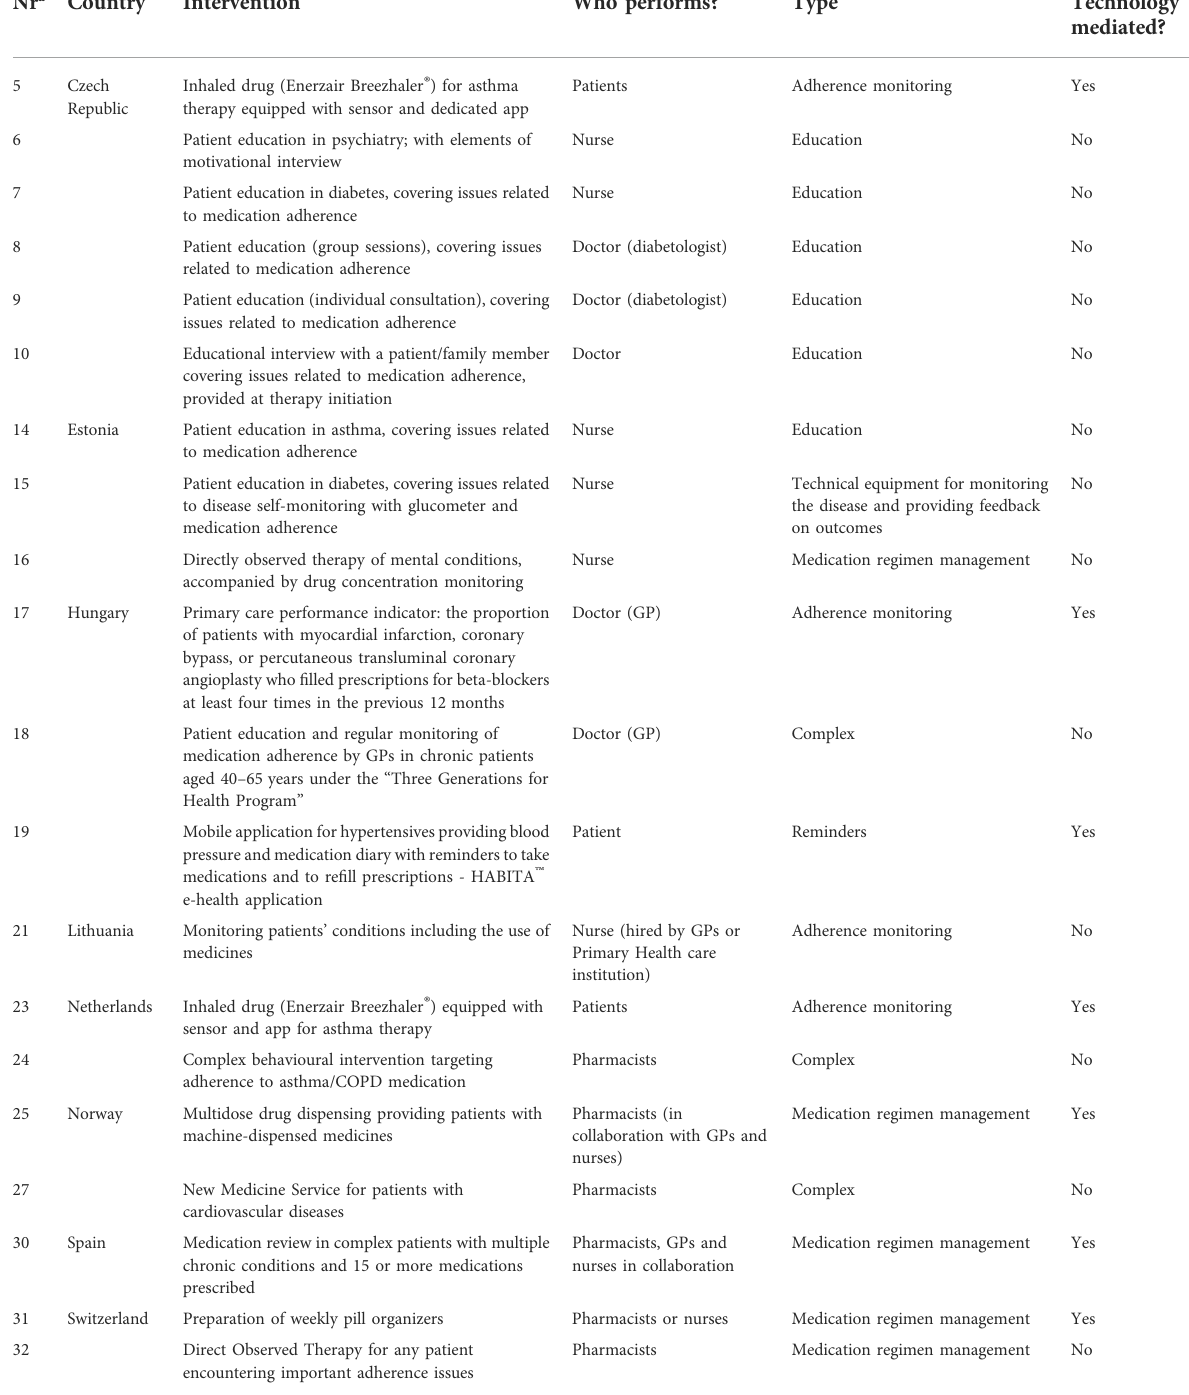
TABLE 3 Detailed characteristics of reimbursed MAEIs directly targeting adherence, identi fi ed across 12 European